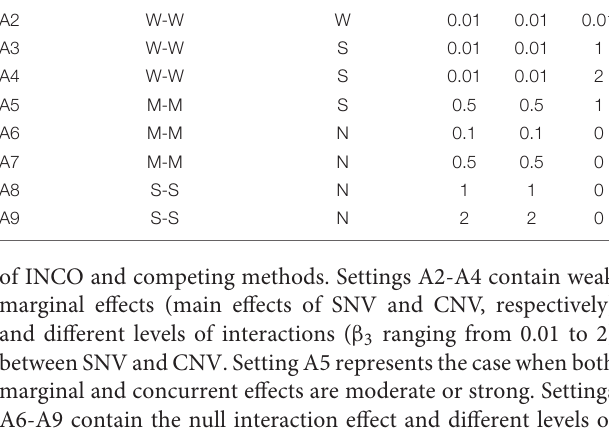
TABLE 2 | The list of settings and parameter values in simulation Part A, where W stands for weak, M moderate, S strong, and N no effect.